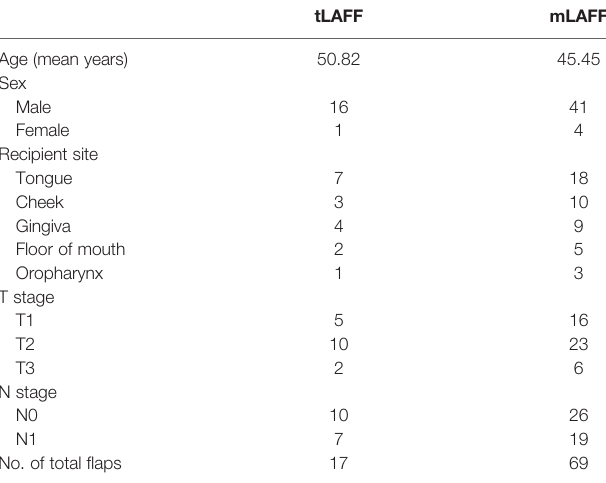
TABLE 1 | Demographics, recipient site, and lesion size of lesions undergoing LAFF reconstruction.